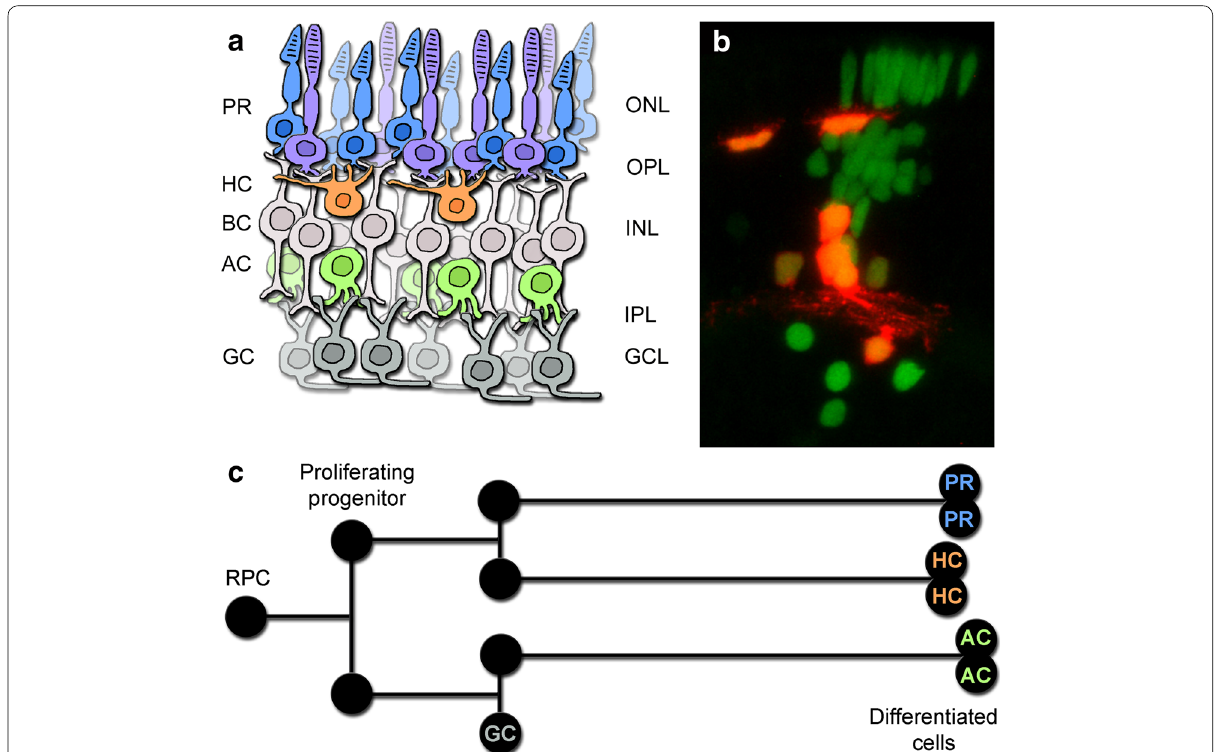
Fig. 2 Retinal architecture and cellular relationships. a The retina is a laminar structure where the cell bodies of cone and rod photoreceptors (PRs) are located in the outer nuclear layer (ONL), horizontal cells (HCs), bipolar cells (BCs), and amacrine cells (ACs) are located in the inner nuclear layer (INL), and ganglion cells (GCs) are situated in the ganglion cell layer (GCL). These nuclear layers are interspersed by the outer and inner plexiform layers (OPL/IPL) containing the neural connections. b Transplantation strategies in zebrafish allow visualization of the clonal expansion performed by a single retinal progenitor cell (RPC) of the optic cup. Here, H2B‑GFP is used to label all cells while Ptf1a‑dsRed marks horizontal and amacrine cells [43]. These results demonstrate the multipotency of RPCs and highlight the close relationship between some cell types. c Additional studies have shown that horizontal cells and photoreceptors often share a common progenitor. The lineage also visualizes the different types of cells where retinoblastoma may